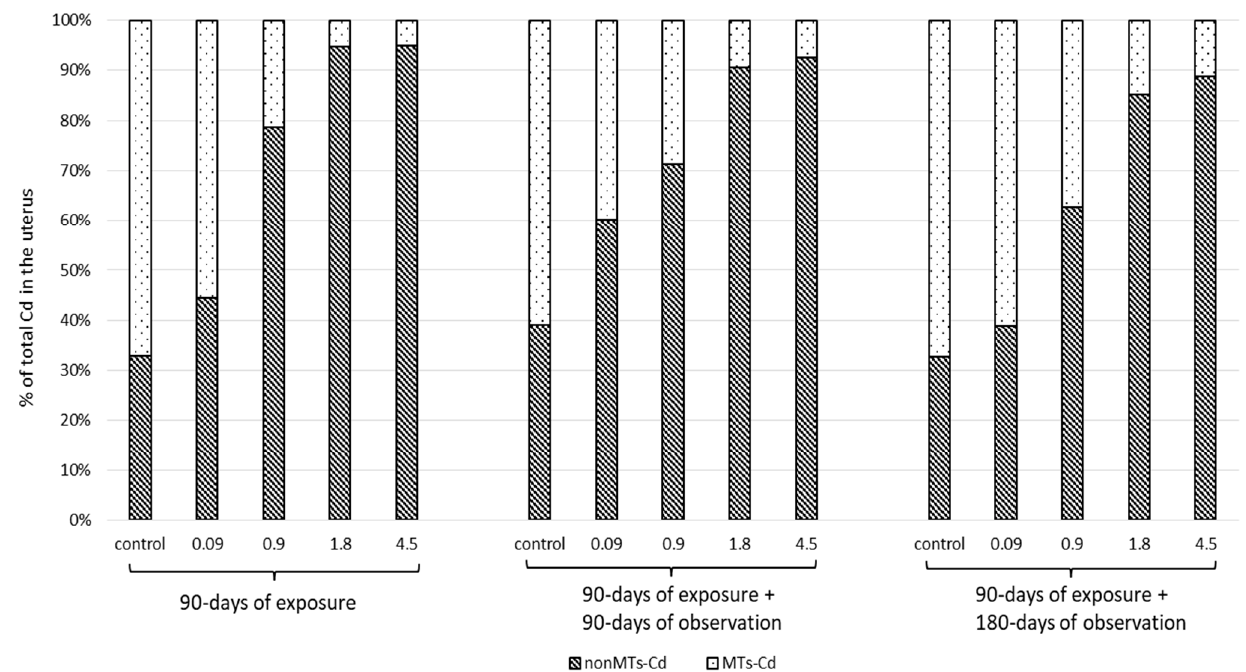
Figure 1 . Cd bound to MT (MT ‐ Cd) and Cd not bound to MT (nonMT ‐ Cd) in the % pool of T ‐ Cd in Figure 1. Cd bound to MT (MT-Cd) and Cd not bound to MT (nonMT-Cd) in the % pool of T-Cd the uterus following 90 ‐ day oral exposure to CdCl 2 , and at 90 days and 180 days post ‐ exposure.